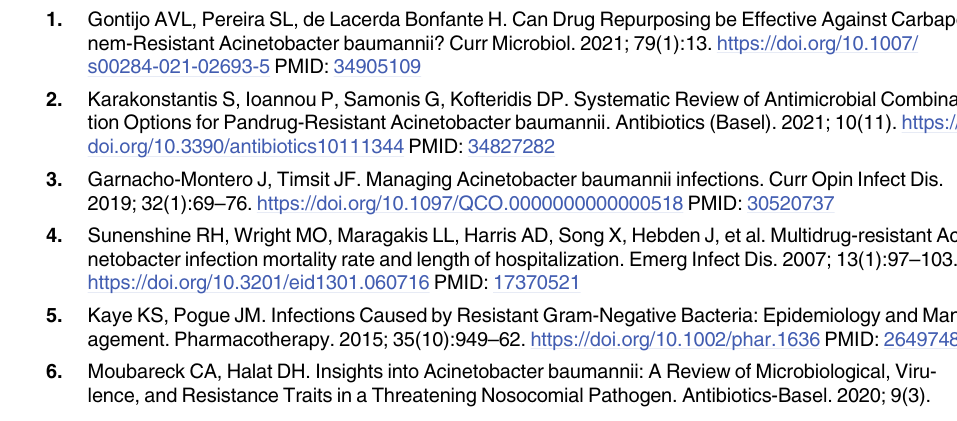
S1 Table. The checkerboard results for the tested clinical strains with colistin combined with other antimicrobials. (I) CST was combined with TGC (a), VAN (b), RIF (c), IMP (d), AMK (e), ATM (f) or CAZ (g) against strain d. (II) CST was combined with TGC (a), VAN (b), RIF (c), IMP (d), AMK (e), ATM (f) or CAZ (g) against strain g. (III) CST was combined with TGC (a), VAN (b), RIF (c), IMP (d), AMK (e), ATM (f) or CAZ (g) against strain j. (IV) CST was combined with TGC (a), VAN (b), RIF (c), IMP (d), AMK (e), ATM (f) or CAZ (g) against strain k. (V) CST was combined with TGC (a), VAN (b), RIF (c), IMP (d), AMK (e), ATM (f) or CAZ (g) against strain